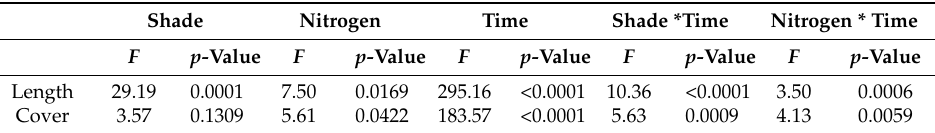
Table 2. F statistics and P - values from Type III tests of the fixed effects of shade, nitrogen, time, and the interaction effects of shade and time and nitrogen and time from mixed effects models with response variables of Idaho fescue shoot length and foliar cover.